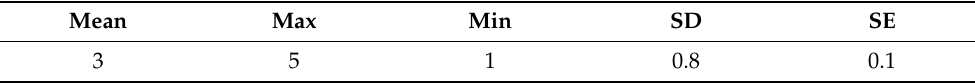
Table 8. Descriptive statistics for items regarding the attention paid to emotional messages.